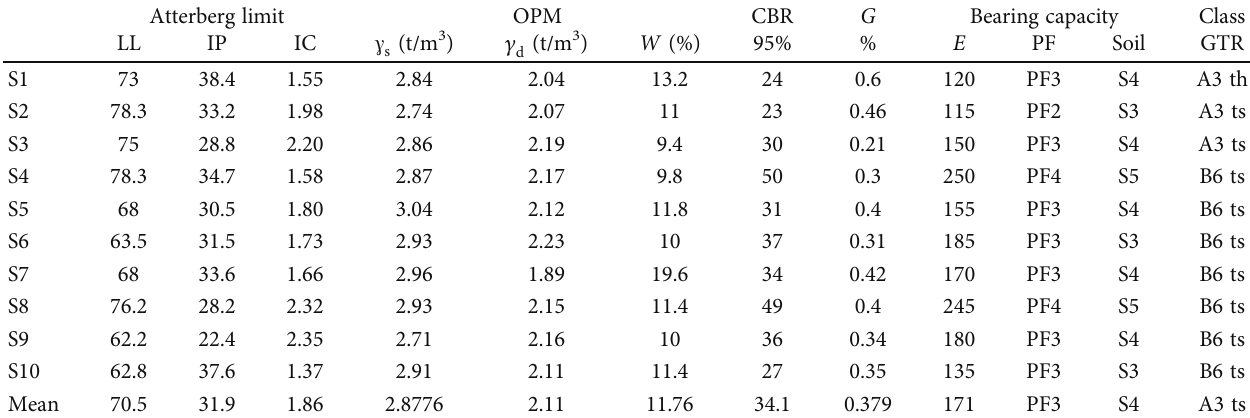
Table 7: Geotechnical results in the plutonic